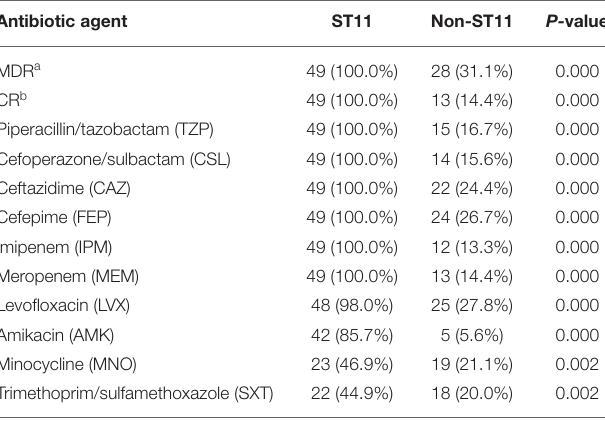
TABLE 2 | Antibiotic resistance patterns of ST11